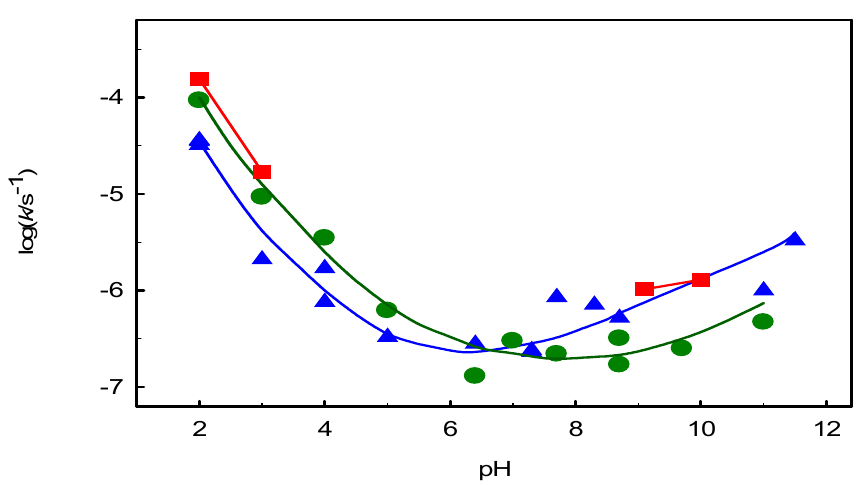
Figure 5. Rate constants for the total disappearance of dinucleoside pyrophosphates 1a (dASppA: green circles), 1b (dASeppA: red squares) and 3 (3 ′ ,5 ′ -dTSppA: blue triangles) as a function of pH at 363 K. The lines are manually drawn to emphasise the trend.